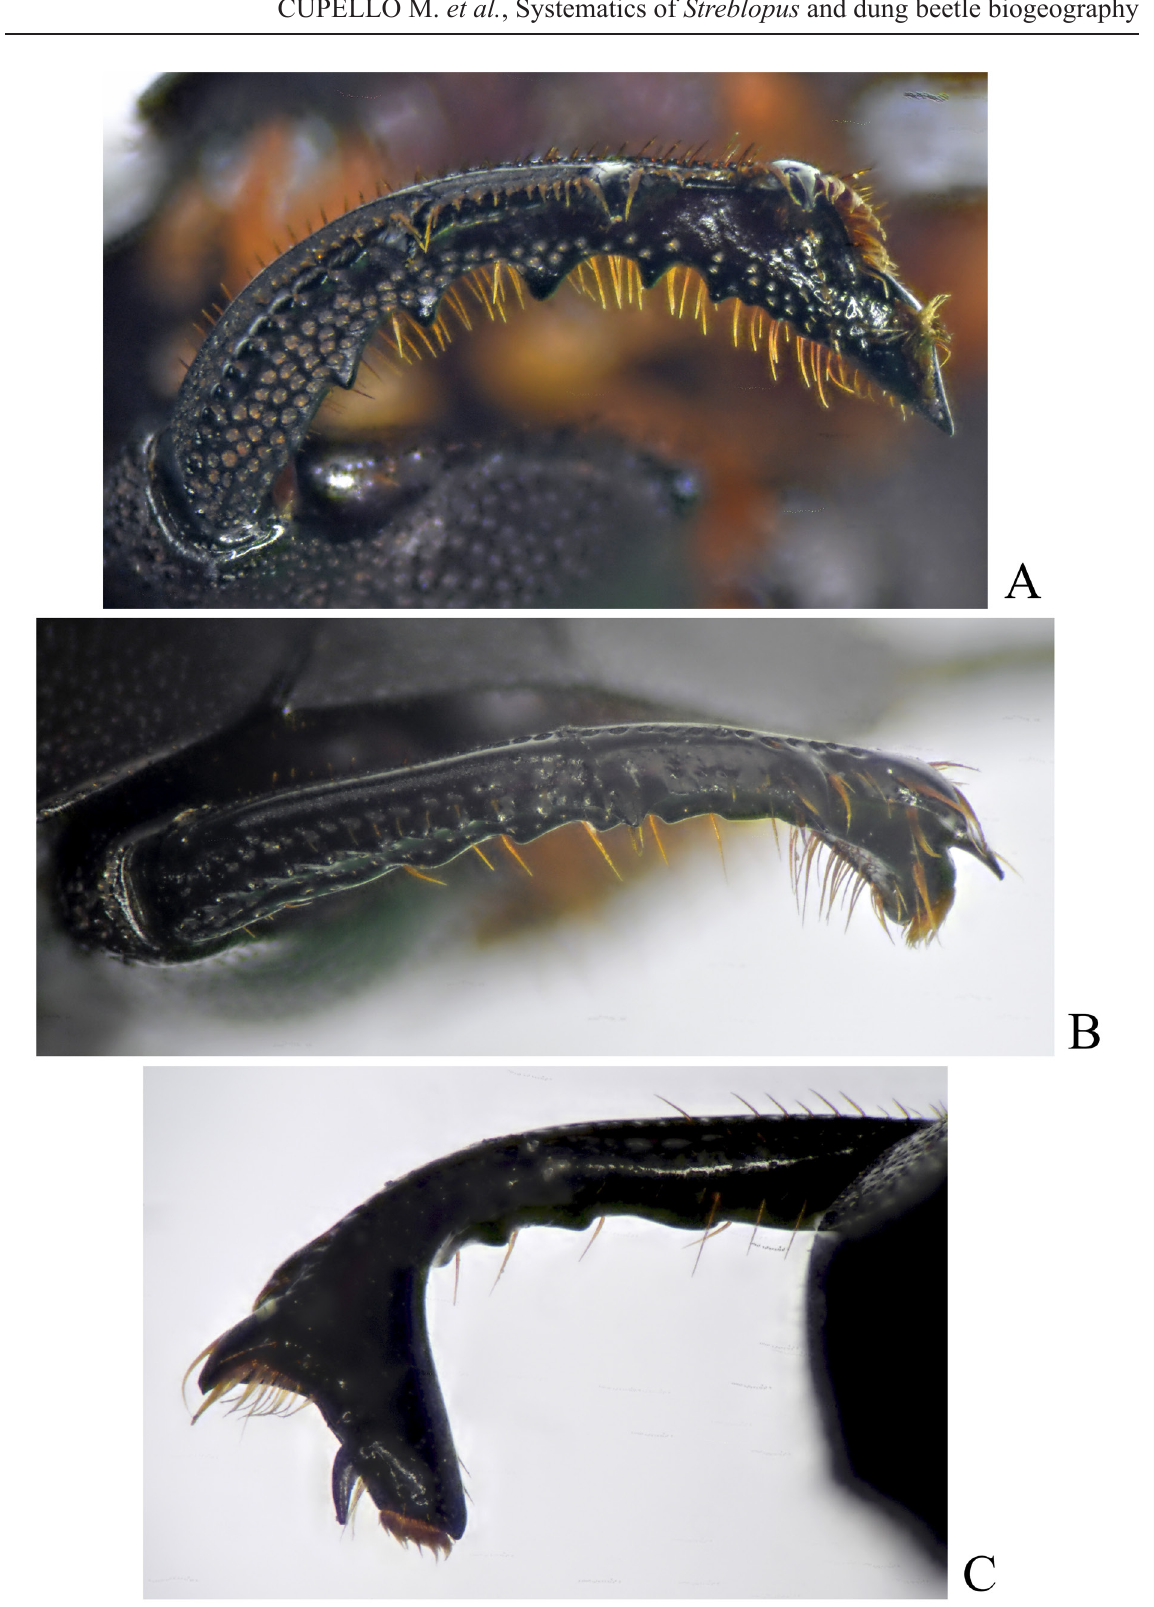
Fig. 16. Protibiae. A‒B . Lateral view. A . Streblopus opatroides van Lansberge, 1874. B . S. punctatus (Balthasar, 1938). Note the how the protibia of S. opatroides is much more curved than that of S. punctatus . C . Frontal view of the protibia of S. punctatus . Note the presence of a protibial